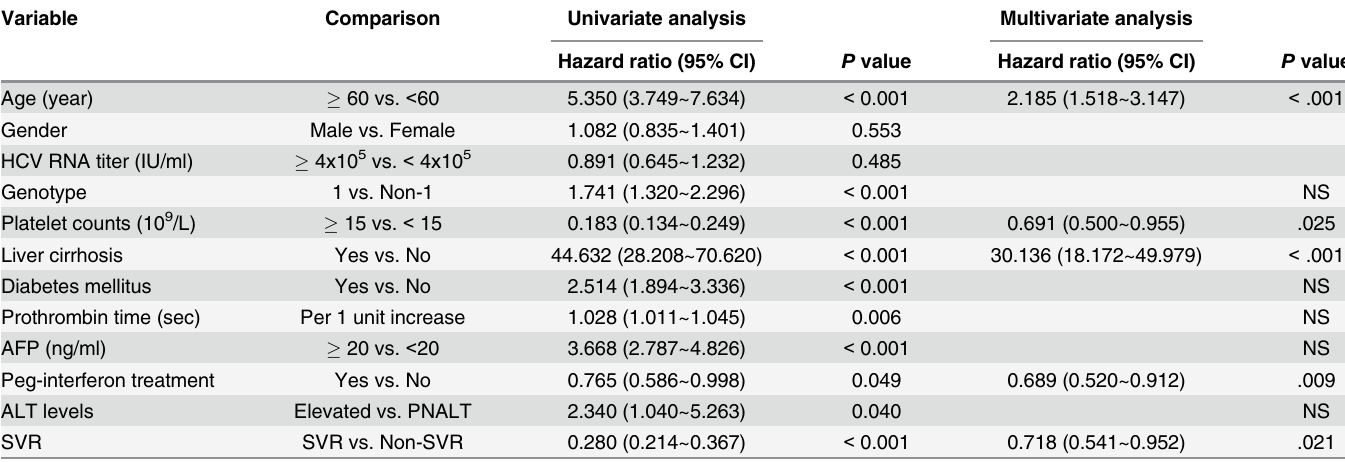
Table 4. Univariate and Multivariate analysis of risk factors associated with occurrence of